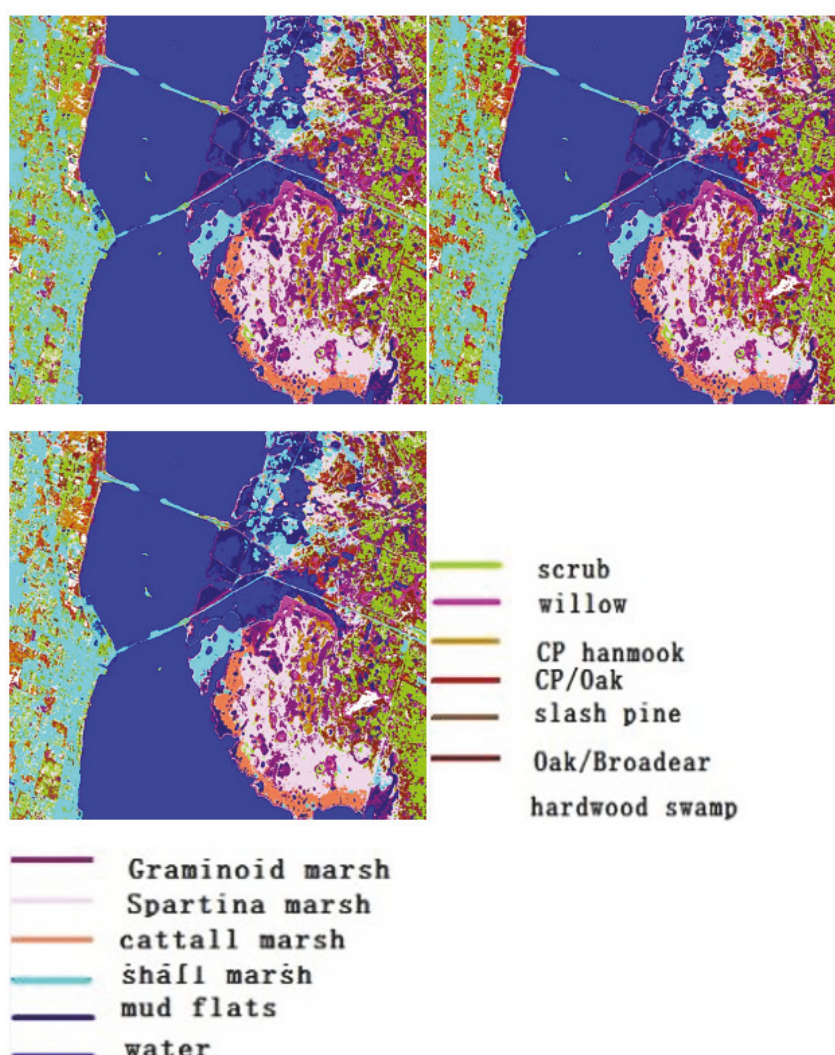
Figure 15: The classification results of support vector machine algorithm for AVIRIS